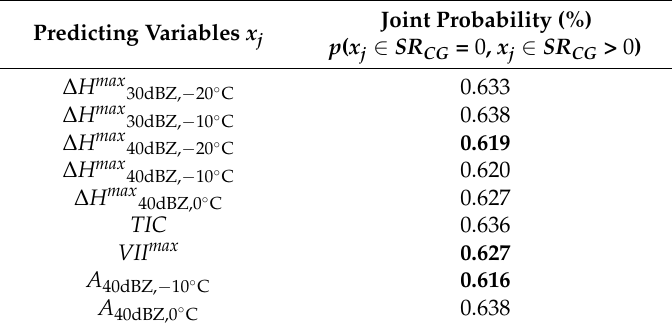
Table 5. Estimate of the separation distance between the histograms in Figure 3 obtained for SR CG = 0 and for SR CG > 0 for the radar-based stroke predictors selected from correlation analysis. The results are presented in terms of joint probability (%). Bold numbers indicate the predicting variable showing the lower overlap between the histograms in each homogeneous dataset.